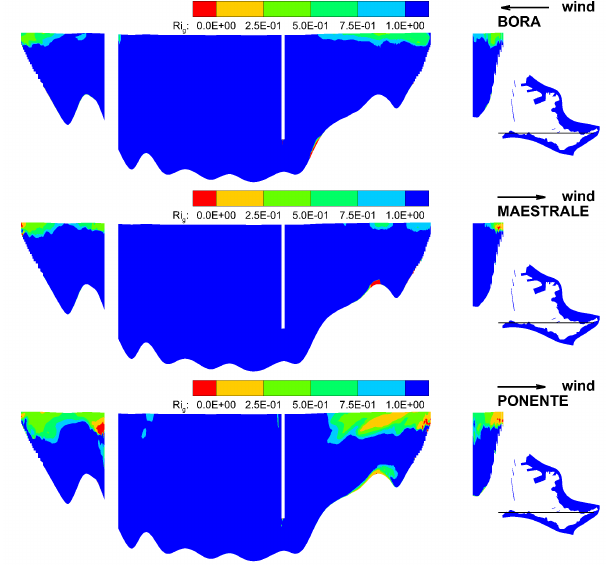
Fig. 20. Contour plot of the vertical eddy viscosity, averaged on a Fig. 20. Contour plot for the vertical eddy viscosity, averaged on a time of 3h, in the vertical cut indicated in the small picture on the time of 3 hours, in the vertical cut indicated in the small picture on right side. Solid lines represent the density anomaly. From top to Fig. 20. Contour plot for the vertical eddy viscosity, averaged on a the right side. Solid lines represent the density anomaly. From top bottom the plots refer to the Bora, Maestrale and Ponente scenarios. Fig. 20. Contour plot for the vertical eddy viscosity, averaged on a to bottom the plots refer to Bora, Maestrale and Ponente scenarios. time of 3 hours, in the vertical cut indicated in the small picture on The vertical direction is magnified by a factor 100. time of 3 hours, in the vertical cut indicated in the small picture on The vertical direction is magnified by a factor 100. the right side. Solid lines represent the density anomaly. From top the right side. Solid lines represent the density anomaly. From top to bottom the plots refer to Bora, Maestrale and Ponente scenarios. to bottom the plots refer to Bora, Maestrale and Ponente scenarios. The vertical direction is magnified by a factor 100. The vertical direction is magnified by a factor 100.